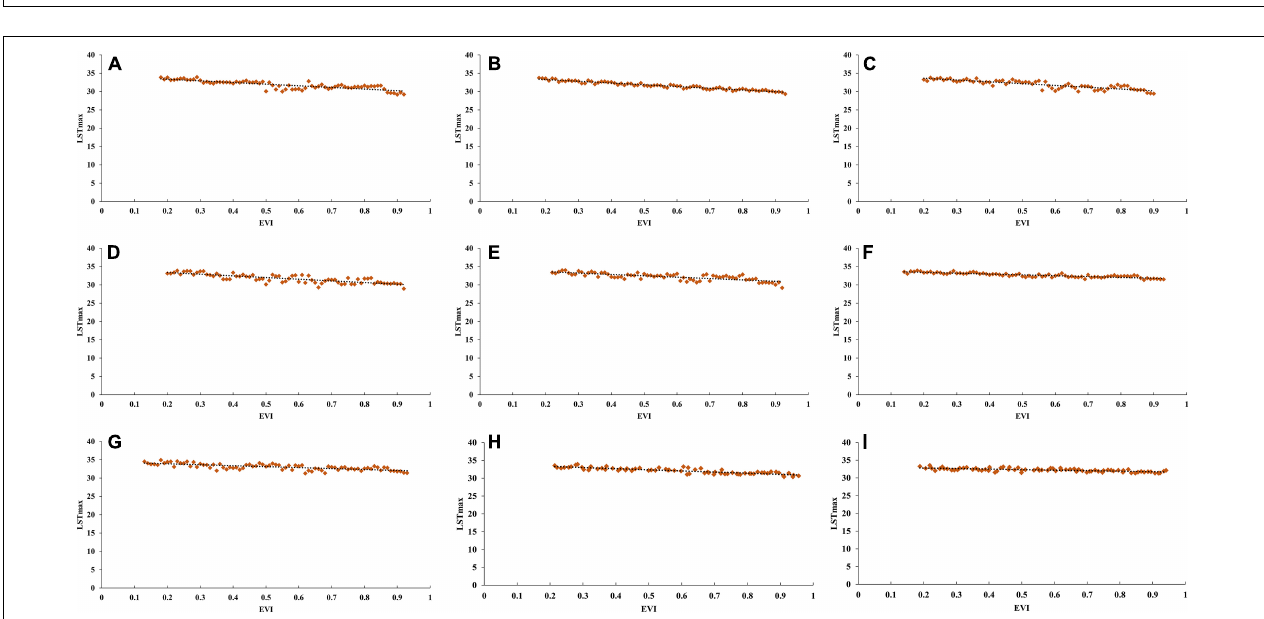
FIGURE 3 | LSTmin-EVI feature spatial fitting map of AGE for (A) 2010, (B) 2011, (C) 2012, (D) 2013, (E) 2014, (F) 2015, (G) 2016, (H) 2017, and (I) 2018.